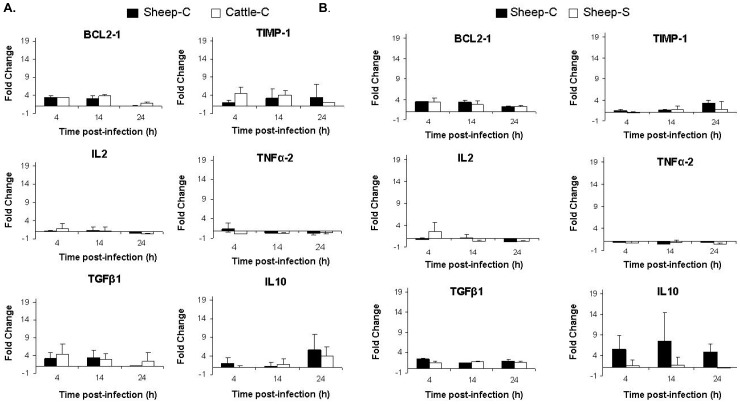
Expression of cytokines and proteins involved in inhibition of apoptosis or tissue destruction in ovine MDMs infected with bovine and ovine isolates of Map.Ovine MDMs were infected with (A) C-type Map isolates from cattle (K10 strain) and sheep (p38I isolate), or with (B) two ovine isolates with C- (p38I isolate) or S-genotype (2349/06-1 isolate). At 4, 14 and 24 h p.i. gene expression was assessed by qRT-PCR. Isolates are identified in the figure by their corresponding host of origin and IS1311 PCR-REA type (C or S). Bars represent the average results of two independent infection experiments (± SD). No statistically significant differences in the expression of the indicated genes between the tested isolates were observed.